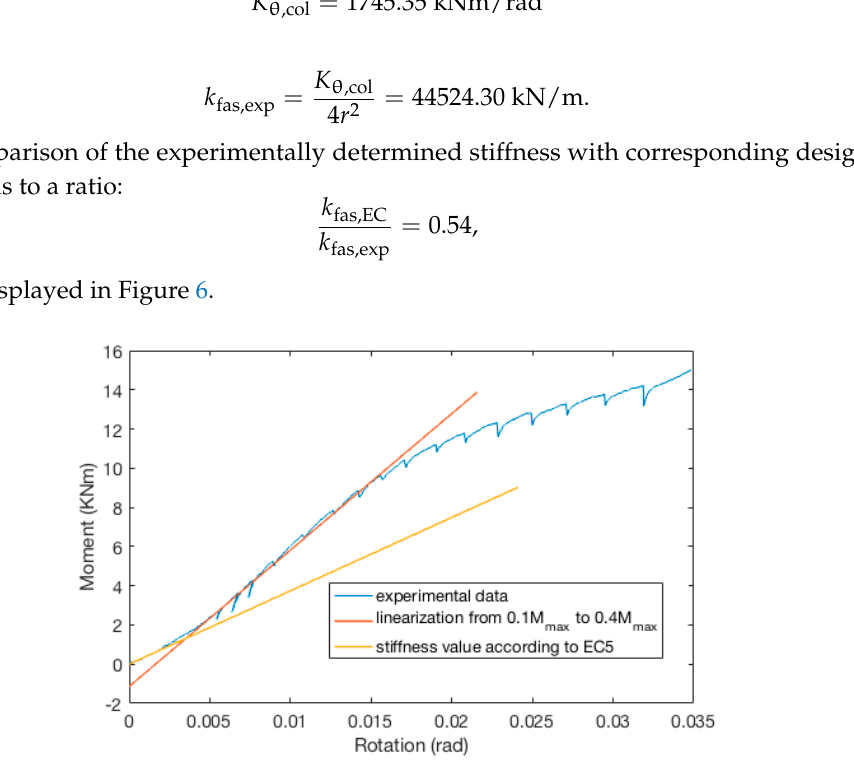
Figure 6. Comparison of experimental rotational stiffness to the Eurocode (EC) value.